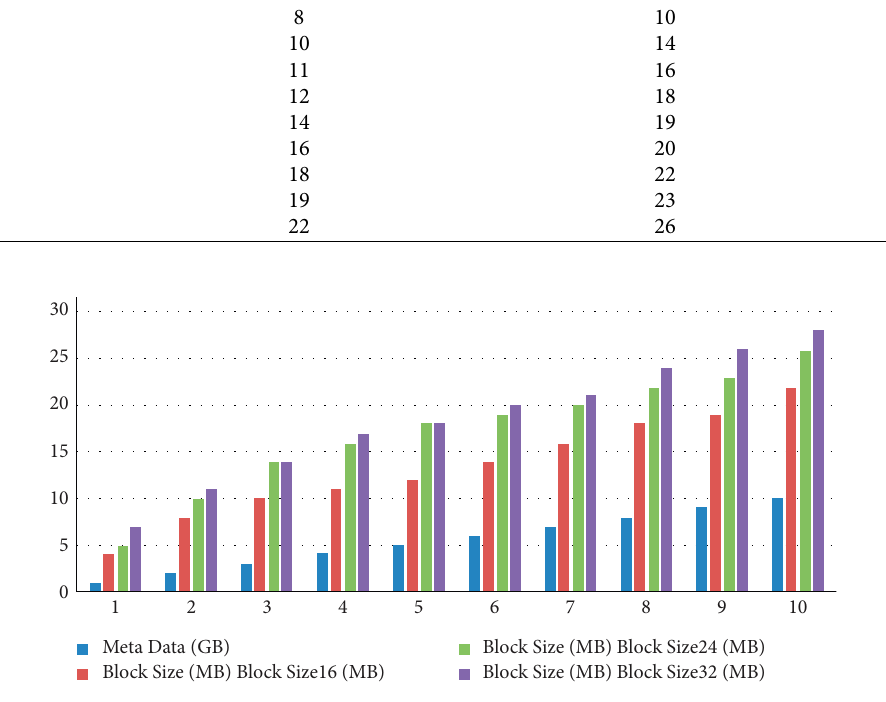
Figure 5: Unstructured metadata generation test.